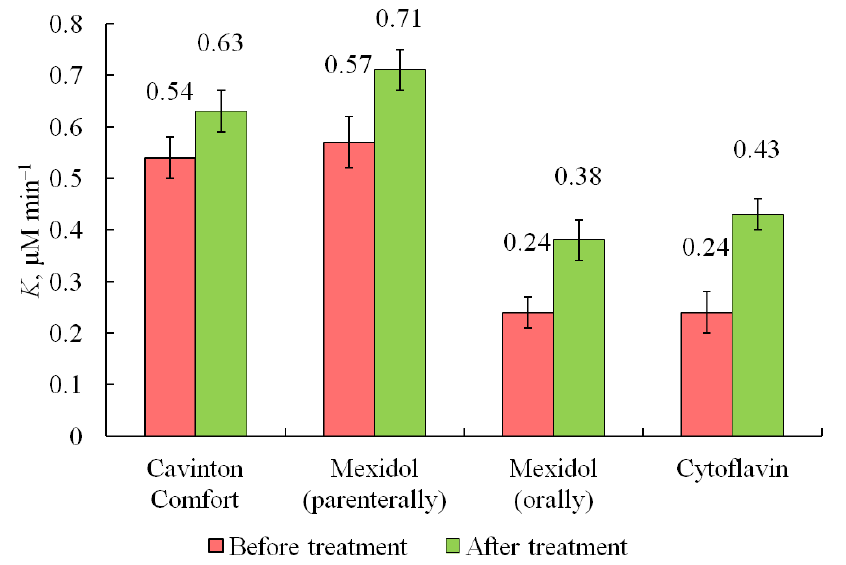
Figure 5. Average values (means ± SD) of the total antioxidant activity in the blood serum of patients with chronic cerebral ischemia during therapy with Cavinton Comfort, Mexidol (parenterally), Mexidol (orally), and Cytoflavin.